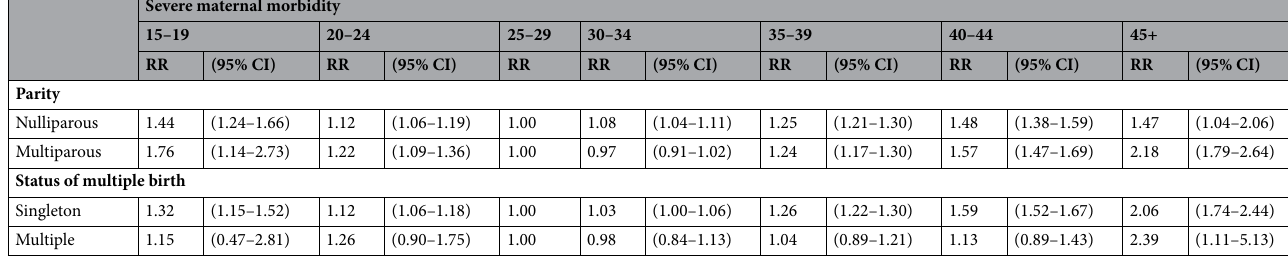
Table 3. The relationship between maternal age and severe maternal morbidity stratified by parity and status of multiple births. Adjusted for household income level, type of insurance, residential area, mode of delivery, adequacy of prenatal care, parity, status of multiple birth, maternal comorbidity, type of hospital, hospital region, and year, except for the stratum